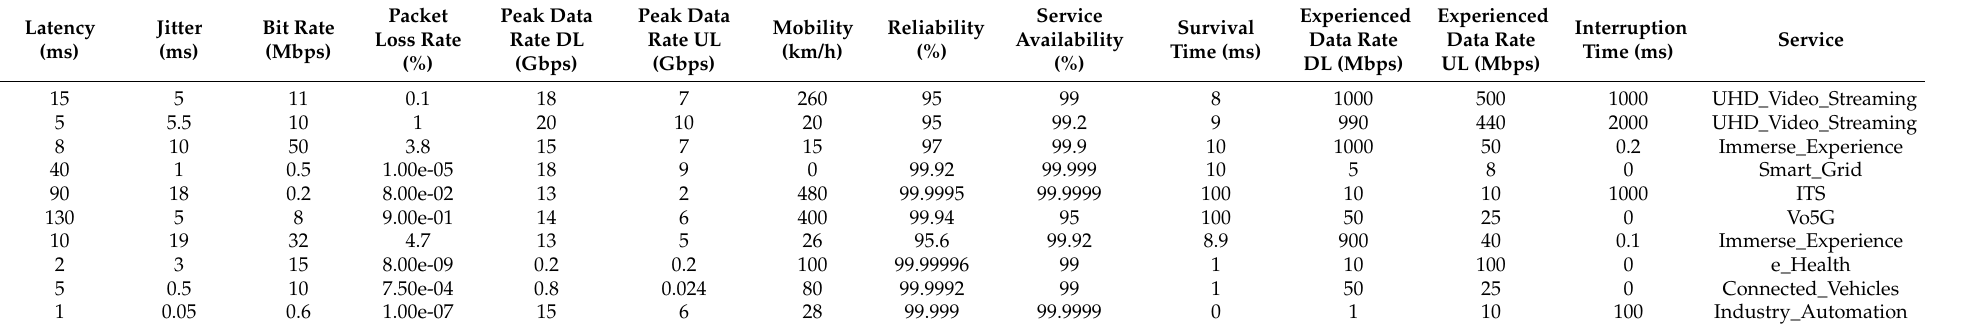
Table 1. Fragment of ten entries of the database